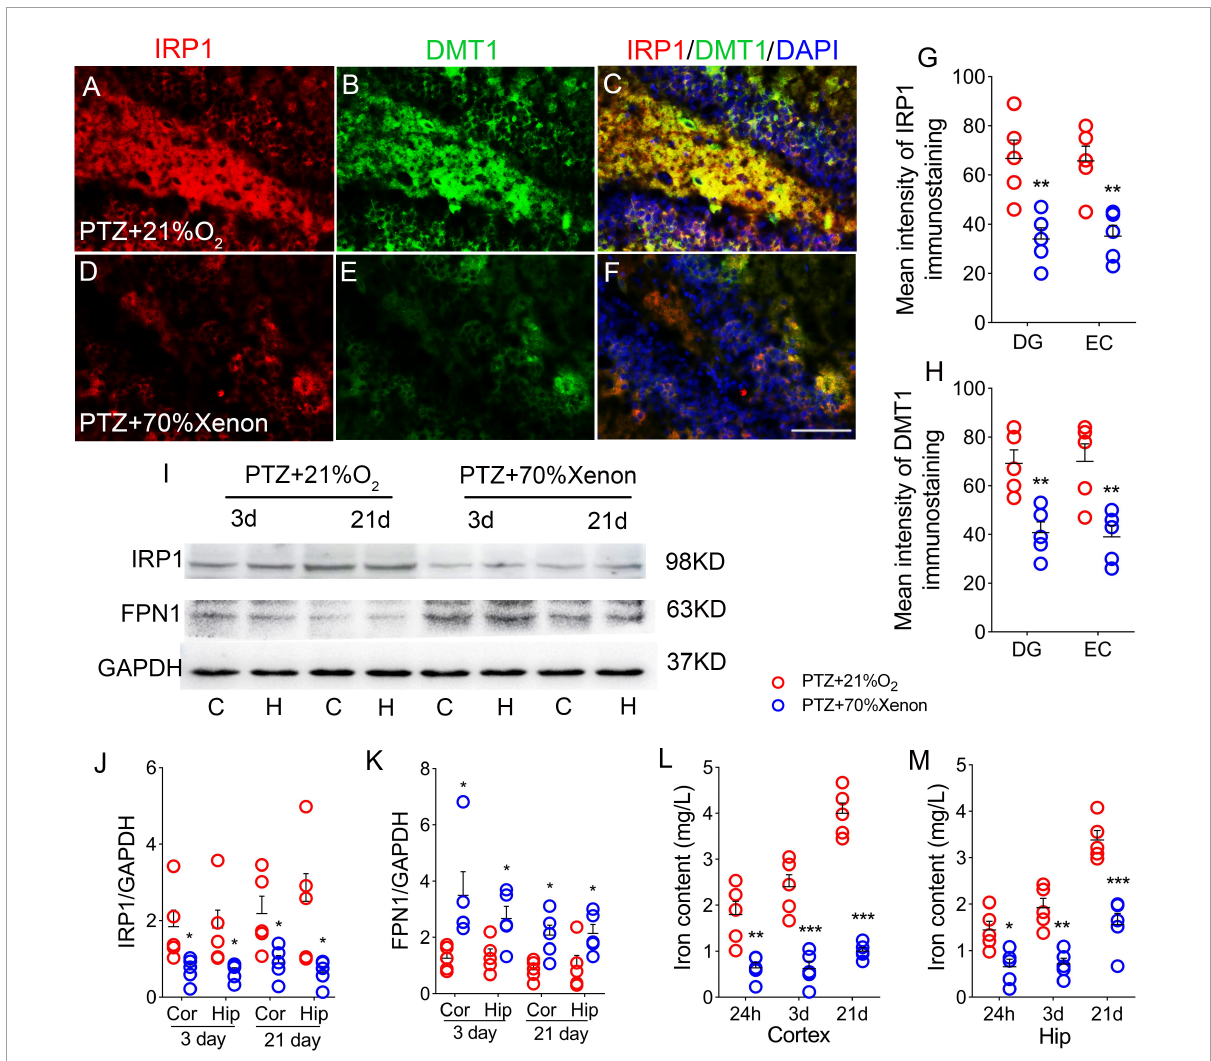
FIGURE6 Xenon treatment reduced the iron accumulation caused by pentylenetetrazole (PTZ). (A–F) Increased levels of IRP1 (red) and DMT1 (green) in the dentate gyrus (DG) region caused by PTZ were attenuated by xenon treatment (blue, DAPI). Bar = 80 µ m. (G,H) Quantified changes in IRP1 and DMT1 ( n = 5/group). (I) Expression of IRP1 and FPN1 in the hippocampus and the cortex estimated by western blotting ( n = 5/group). (J,K) Normalized intensity of IRP1 and FPN1 relative to GAPDH (one-way ANOVA). (L,M) Levels of iron ( n = 5/timepoint). * P < 0.05, ** P < 0.01, and *** P < 0.001, compared with controls (unpaired T